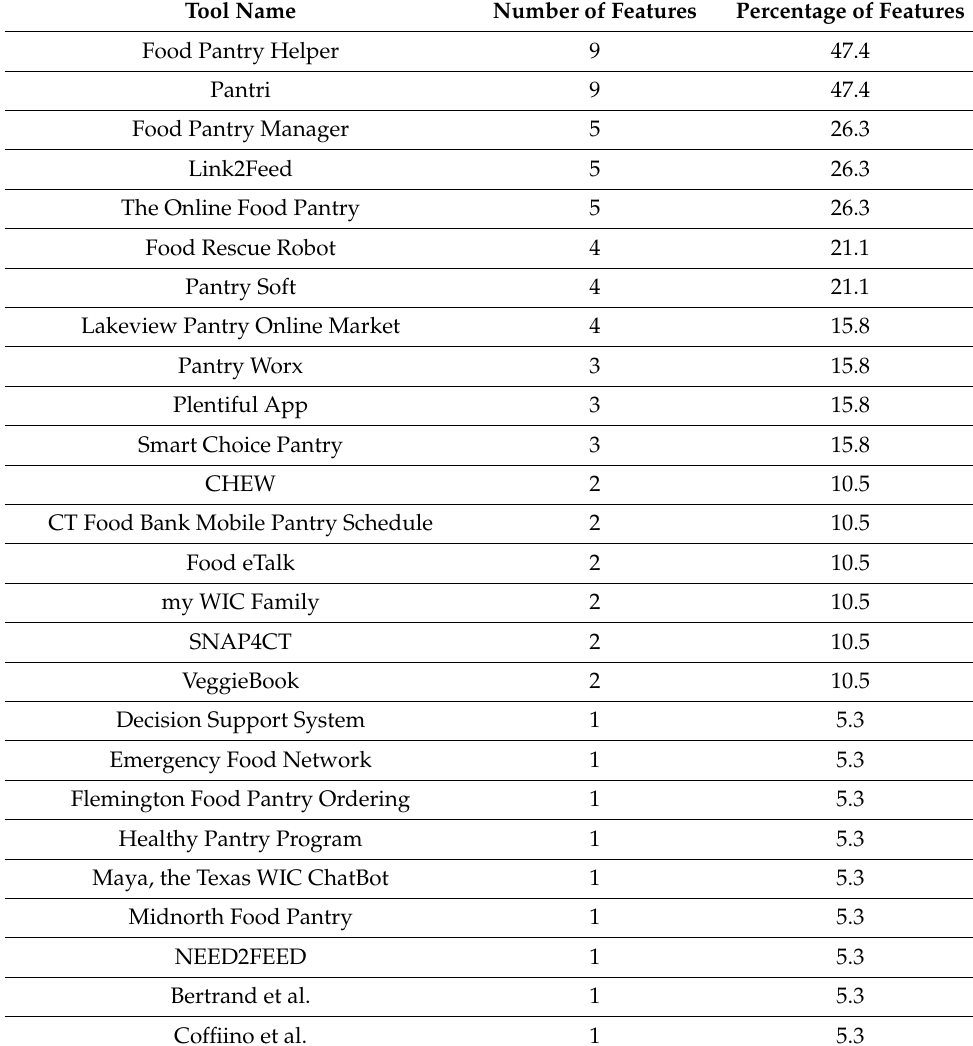
Table 4. Number of features per